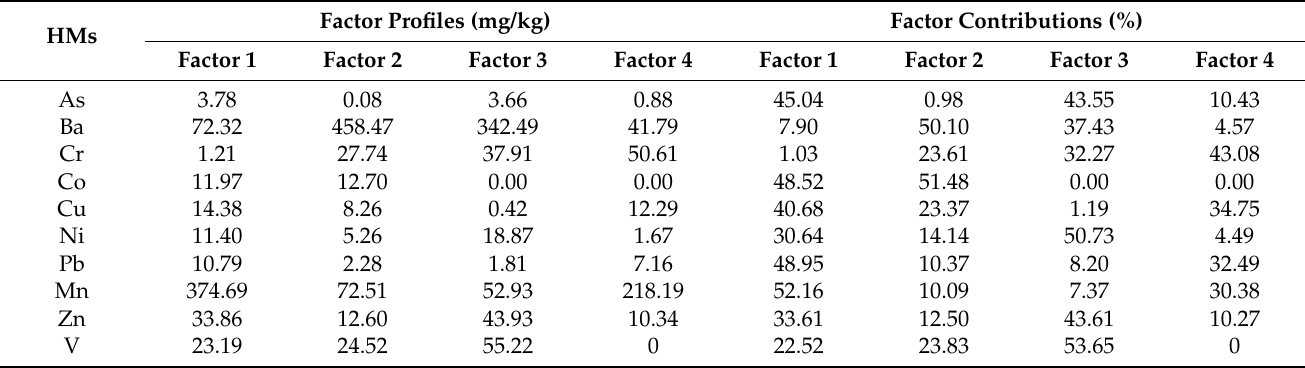
Table 3. Factor profiles and contribution of the factors by